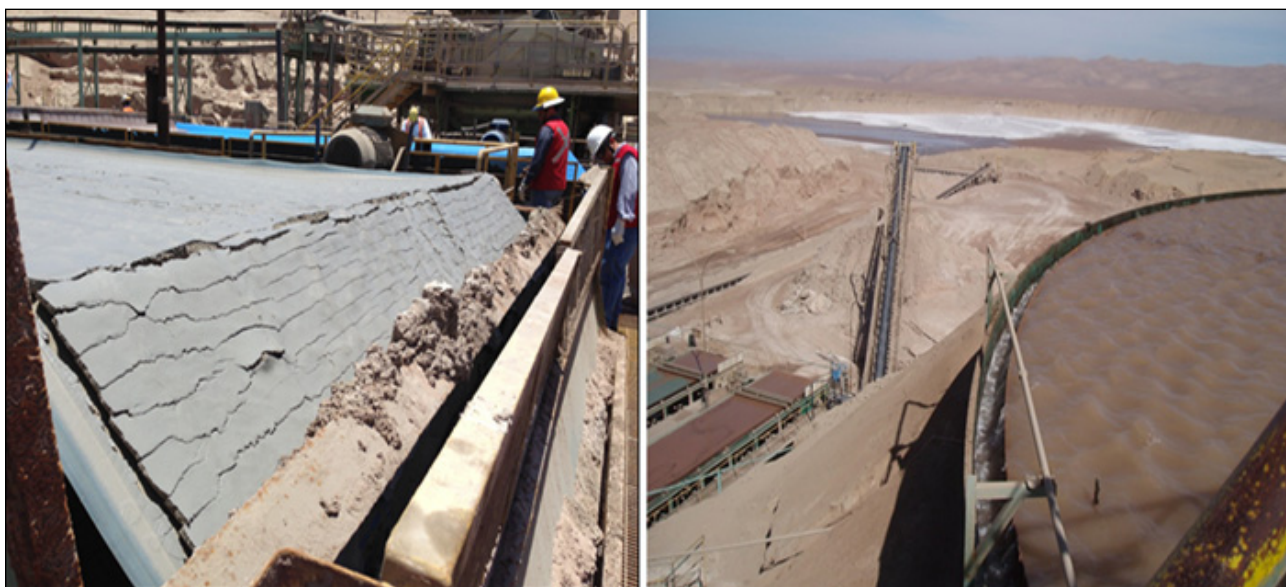
Figure 48. Mantos Blancos Filtered Tailings–Belt Filters and TSF overview [18,67,68].